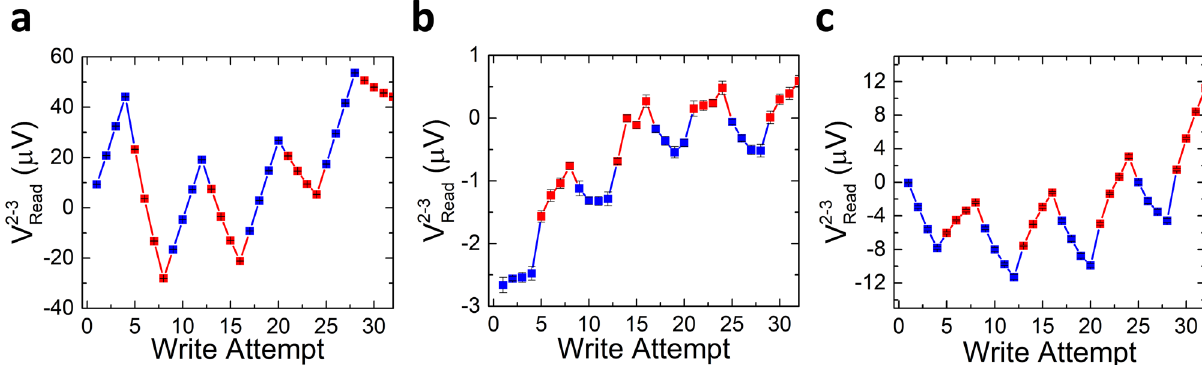
Fig. 4 Measured differential voltage ( V 2-3 Read ) for a Pt control device with 30 mA write pulses. a 90° switching con fi guration when the writing current is applied from electrode 1 to 4 ( I 1-4 write , red squares) and from electrode 6 to 2 ( I 6-2 write , blue squares), b 180° switching when the current pulse is applied from electrode 2 to 6 ( I 2-6 write , red squares) and its reverse ( I 6-2 write , blue squares), and c 180° switching between electrodes 1 and 4 (where I 1-4 write corresponds to red squares and I 4-1 write corresponds to blue squares). In all three cases, we observe a sawtooth-like switching of non-magnetic origin at this higher writing current, which corresponds to a current density of 60 MA/cm 2 in the Pt layer. Each data point corresponds to the mean value of 170 consecutive measurements and the error bar to the standard